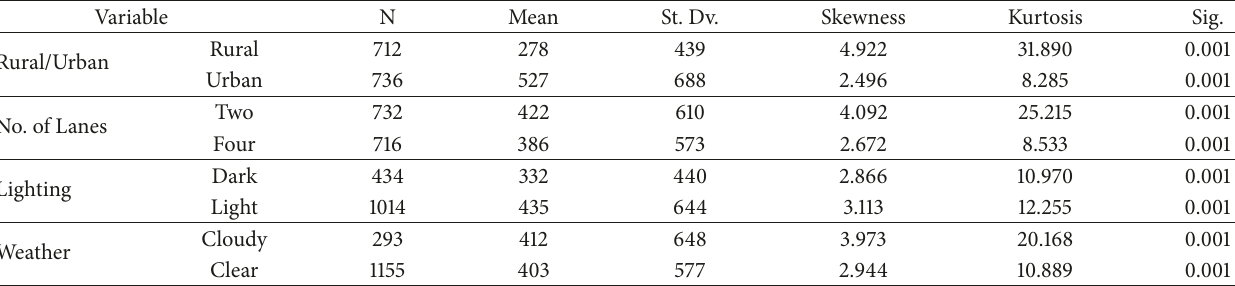
Table 4: Descriptive statistics of the nonsevere crash rates occurring on dry pavement surfaces across the categorical variables and tests of normality for the selected eight